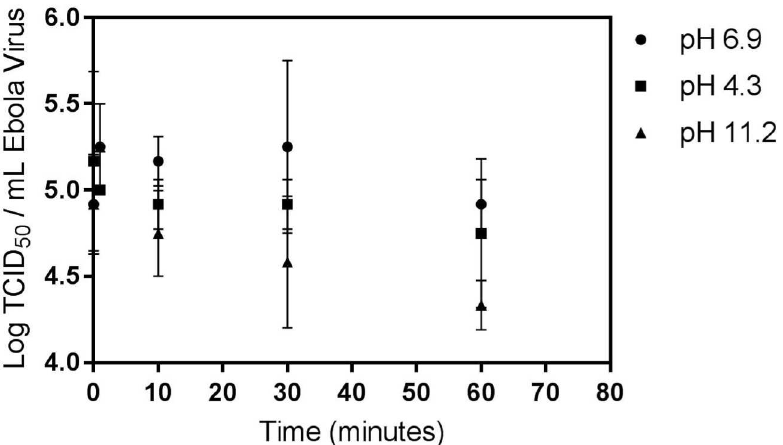
Fig 4. Ebola virus persistence in wastewater at neutral (6.9), acidic (4.3), and basic (11.2) pH. The limit of detectionwas 0.75 log TCID 50 mL -1 . Error bars represent one